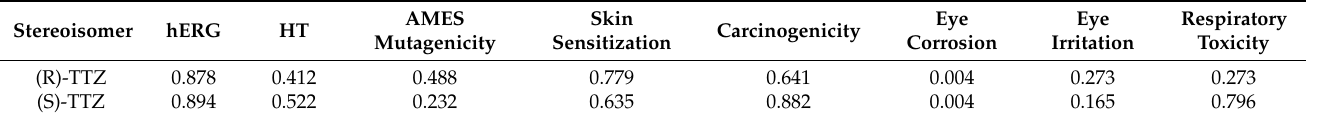
Table 5. Predicted toxicological endpoints of the stereoisomers of triticonazole (TTZ): hERG— cardiotoxicity,